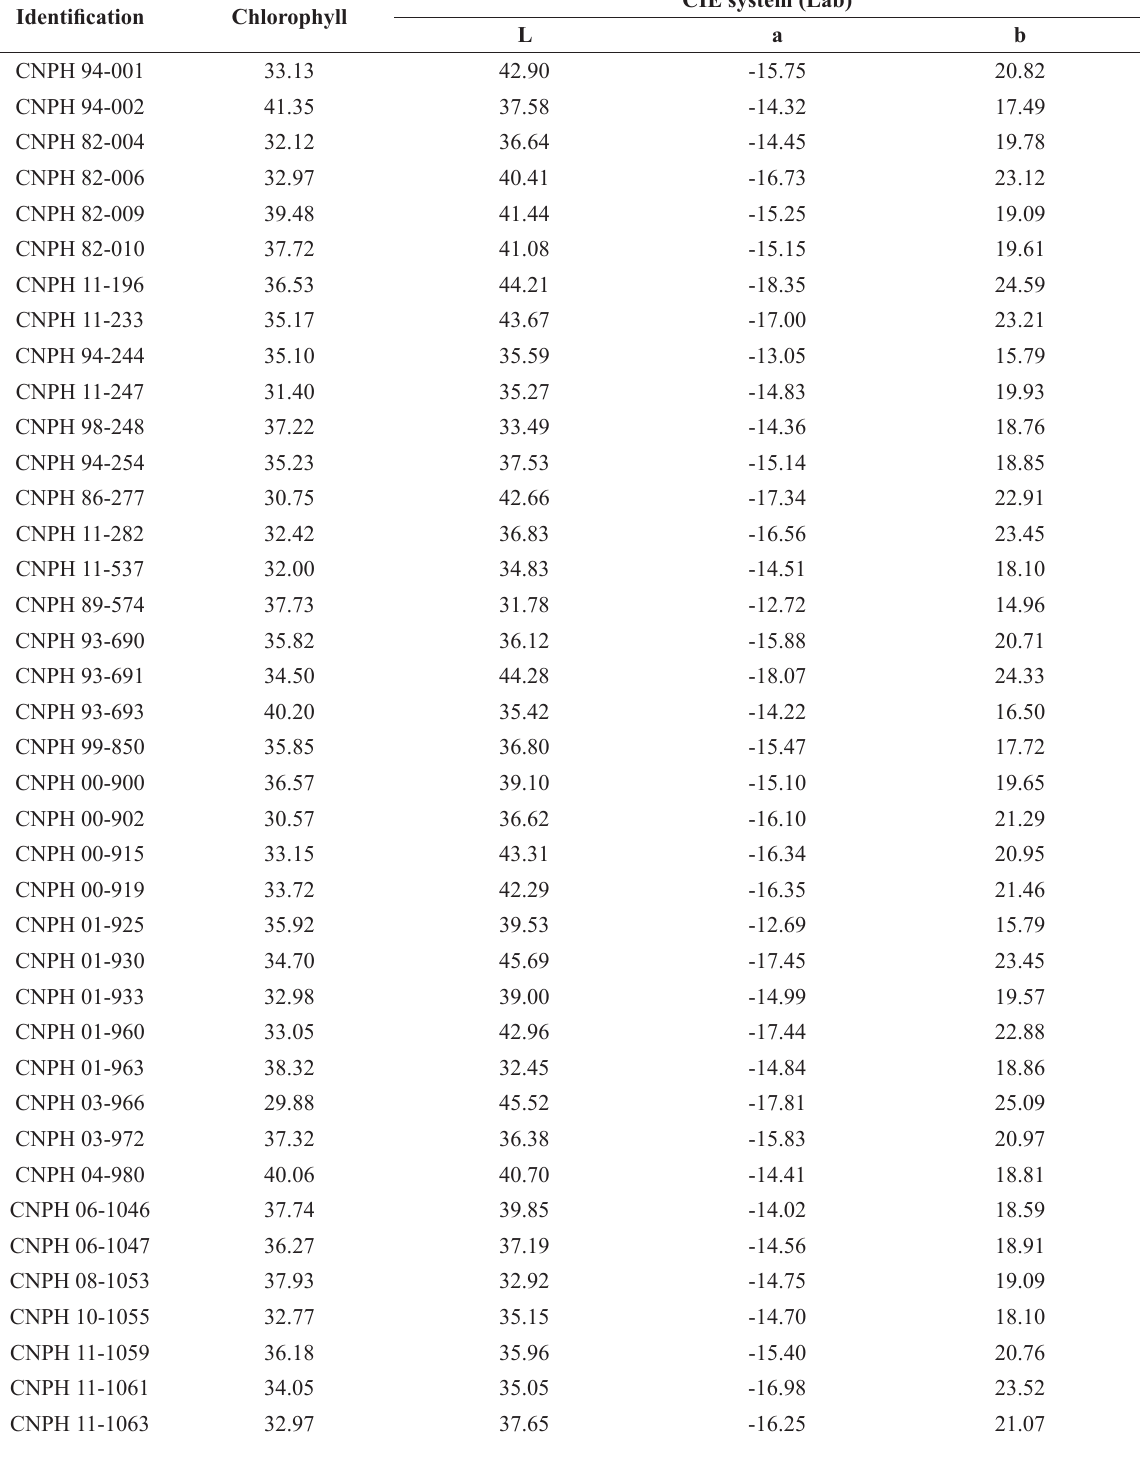
Mean values of the chlorophyll contents and of the colorimetric parameters for the 54 genotypes evaluated in cages, Fortaleza, CE, Brazil,